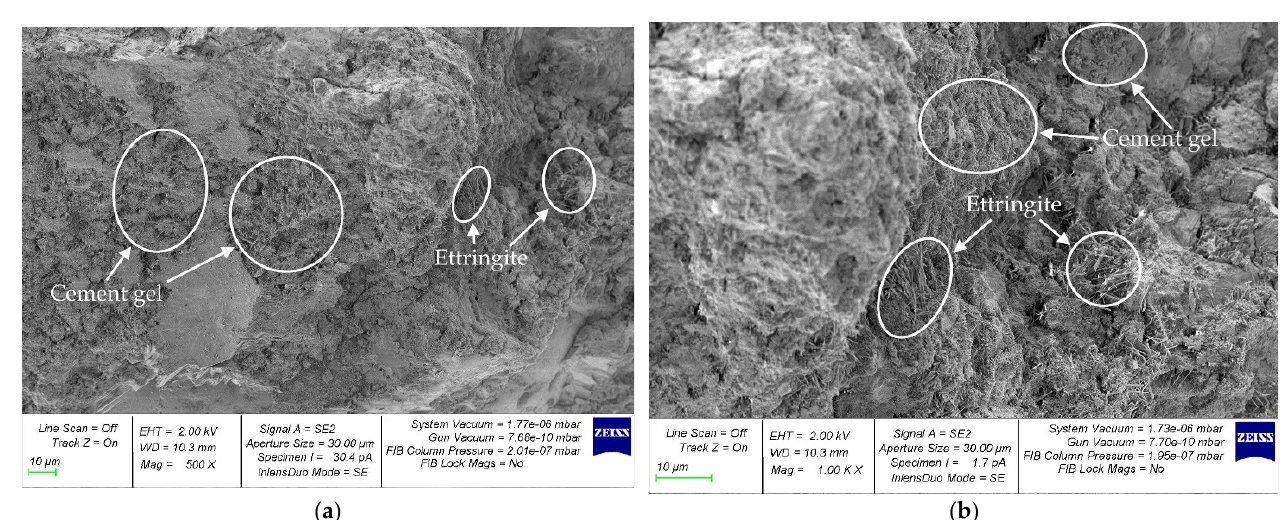
Figure 8. Vibrated samples: ( a ) 500×; ( b ) 1000×.